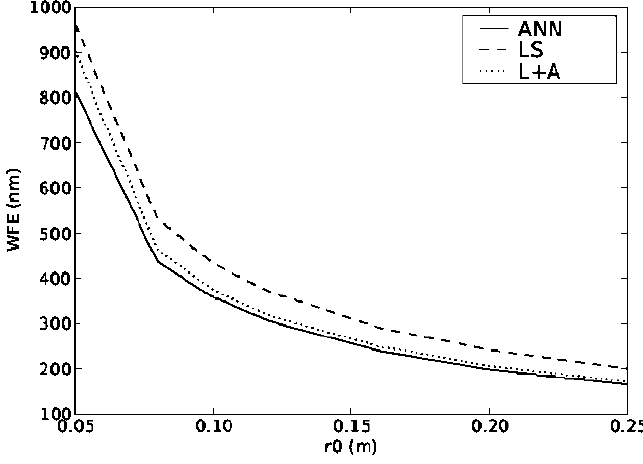
and the outer scale L 0